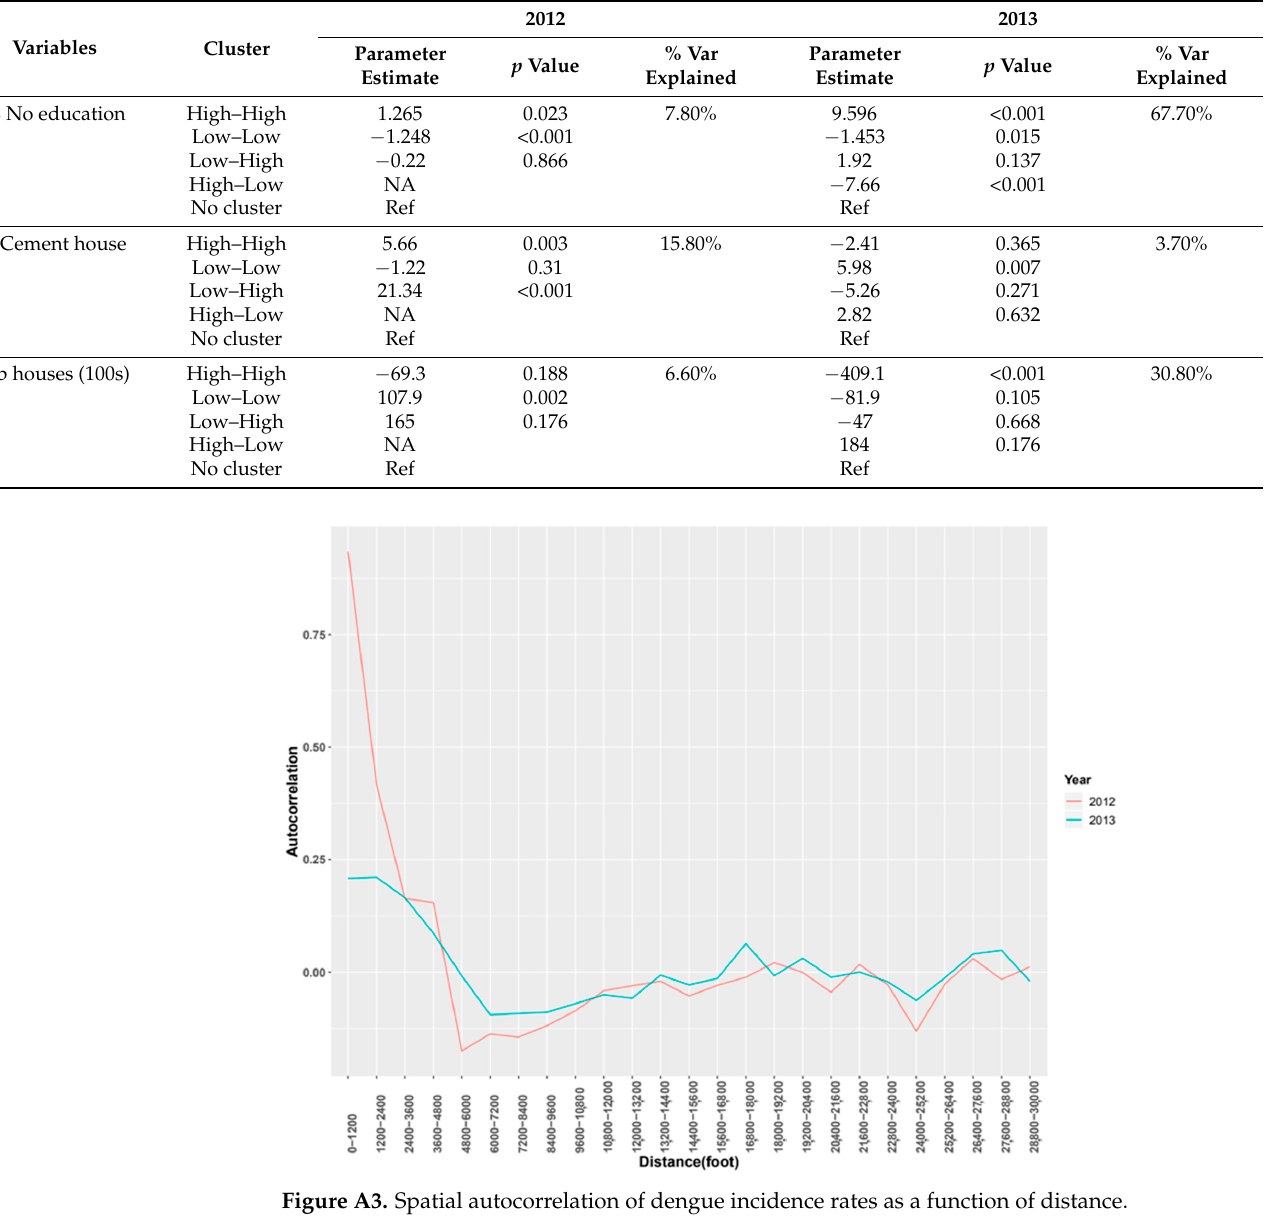
Table A5. Effect of transport weight matrices on the association of clusters with pertinent SE variables.